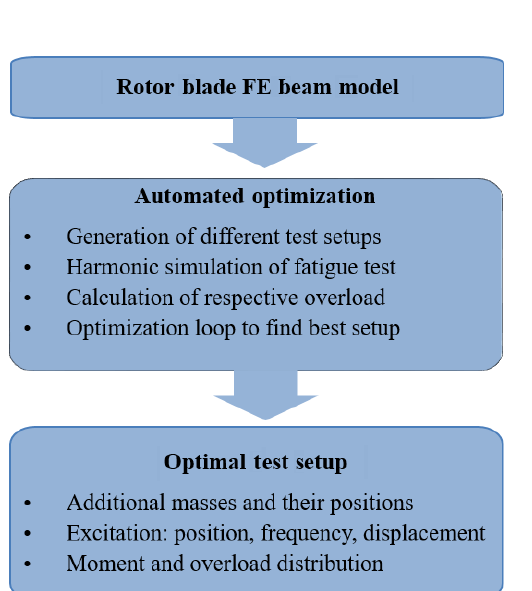
Figure 8. Schematic representation of the root segment fatigue test setup.